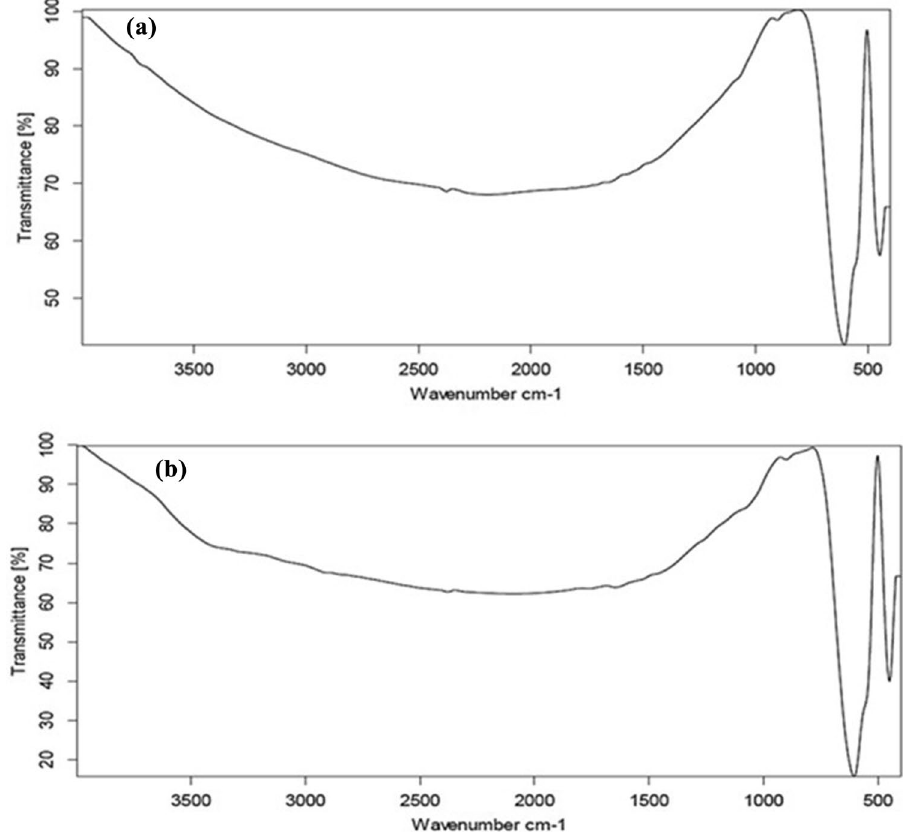
Figure 4. Fourier-transform infrared spectra of the prepared samples ( a ) BFO and ( b )